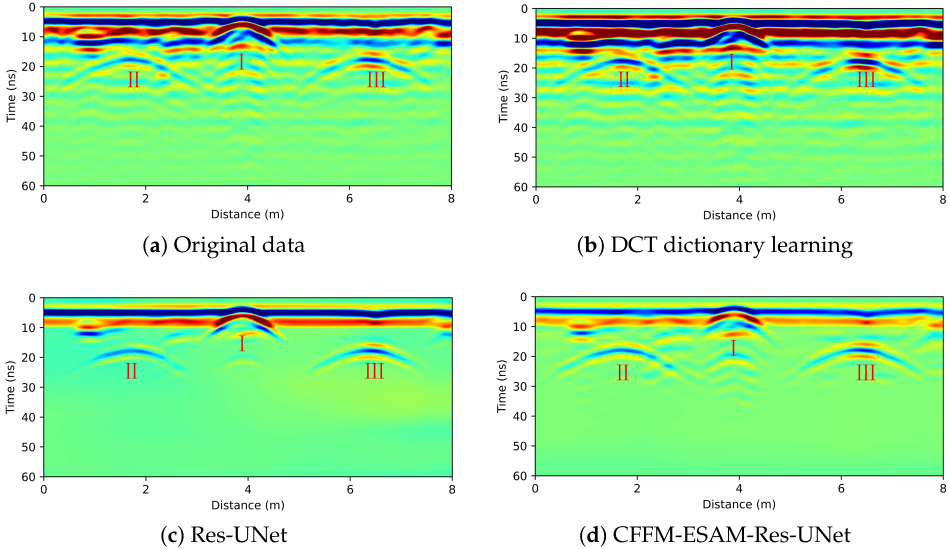
Figure 13. Experimental GPR recording Clutter removal results of different